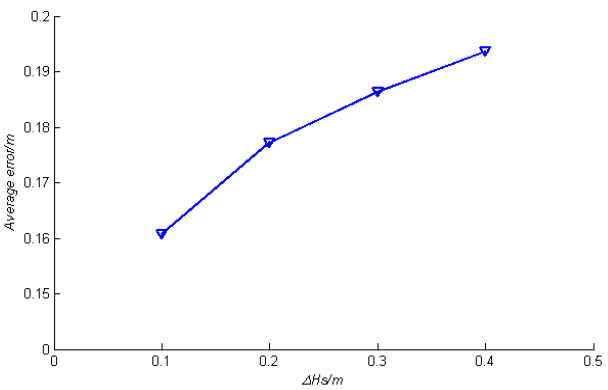
Figure 12. The average error of the wave height prediction data with ∆ H s = 0.1 m, 0.2 m, 0.3 m, 0.4 m.